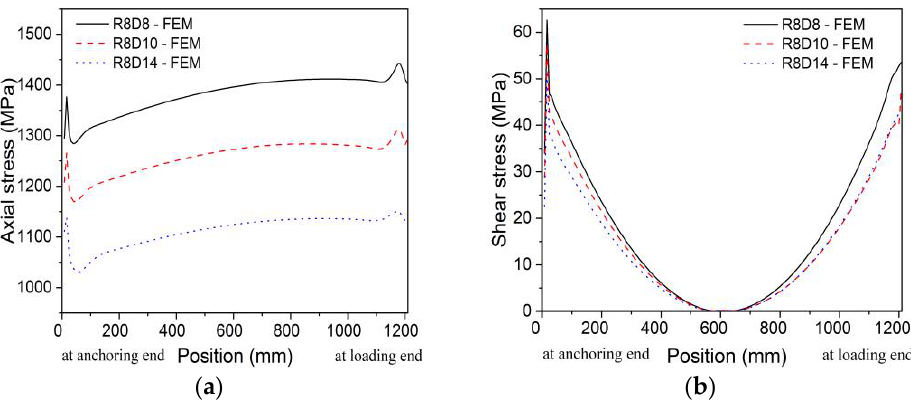
Figure 16. Effect of diameter on the stress distributions of CFRP tendons: ( a ) axial stress; ( b ) shear